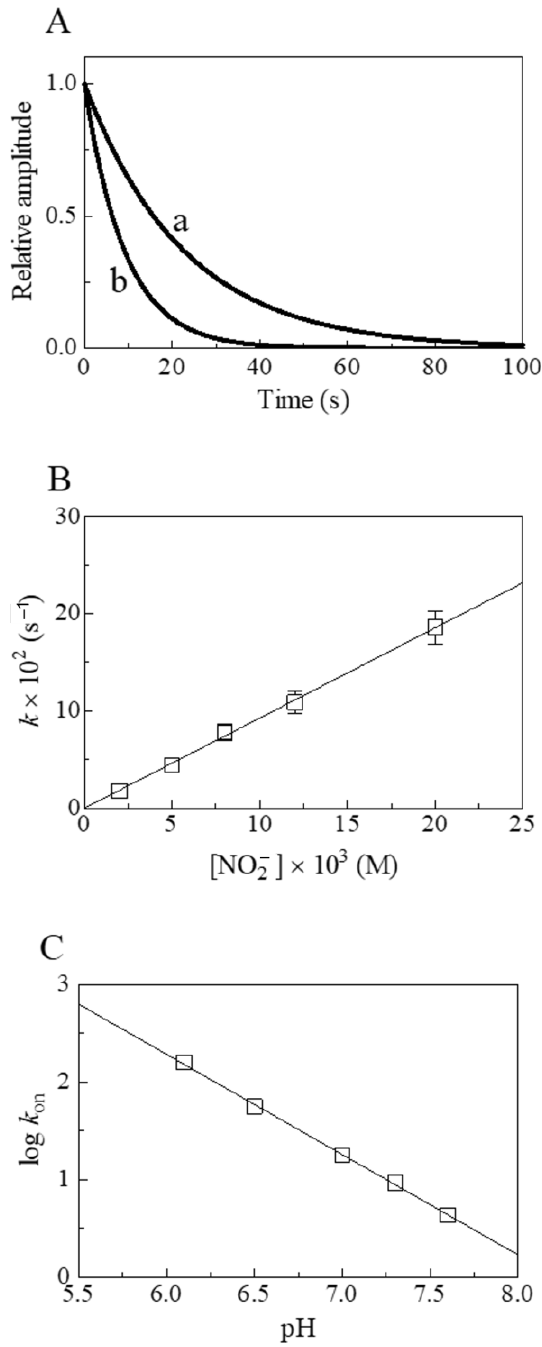
Figure 2. Nitrite reductase activity of At -Nb(II) at 20.0 °C. ( A ) Normalized averaged time courses for the NO 2 − -mediated conversion of At -Nb(II) to At -Nb(II)-NO at pH 7.3 in the presence of 5.0 × 10 −3 M (trace a) and 1.2 × 10 −2 M (trace b) NO 2 − . The time course analysis according to Equation (3) allowed the determination of the following values of k obs : 4.4 × 10 −2 s −1 (trace a) and 1.1 × 10 −1 s −1 (trace b). ( B ) Dependence of k obs on the NO 2 − concentration for At -Nb(II) nitrosylation at pH 7.3. The solid line was calculated according to Equation (4) using k on = 9.3 ± 1.0 M −1 s −1 . ( C ) pH-dependence of log k on for the NO 2 − -mediated conversion of At -Nb(II). The value of the slope of the continuous line is −1.03 ± 0.1 0. Where not shown, standard deviation is smaller than the symbol.